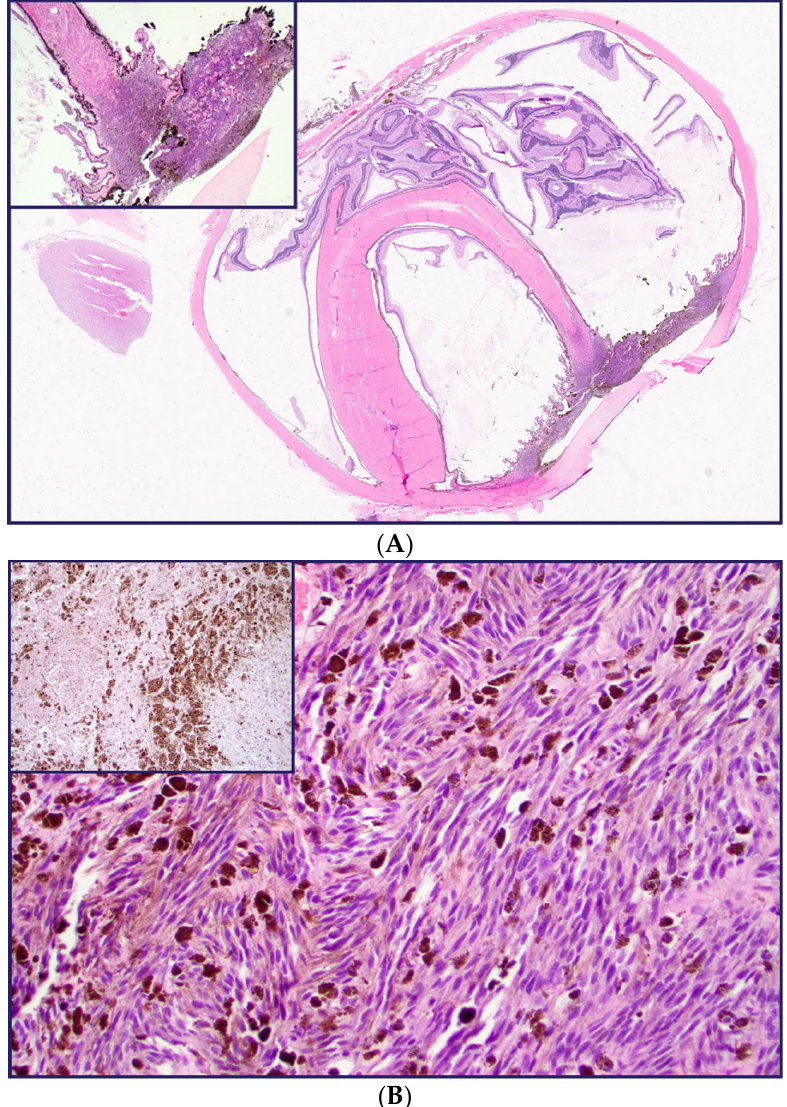
Figure 2. Melanoma from patient #2 ( A ) originating from ciliary body (insert). Tumor sample with spindle-cell morphology ( B ), necrosis, melanophages, secondary to previous treatment